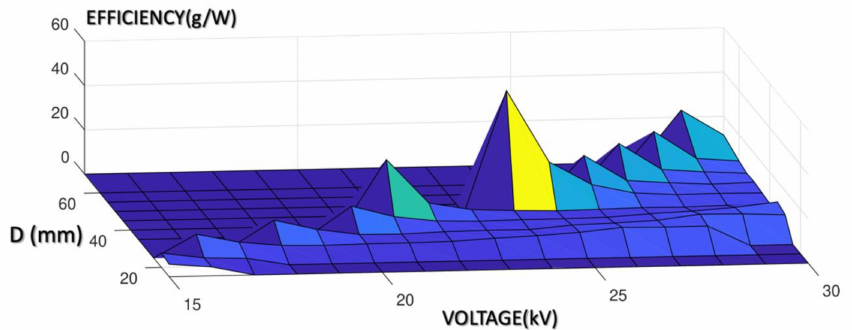
Figure 20. Dual thruster 3D plot, efficiency as thrust/ power ratio, voltage, and distance between